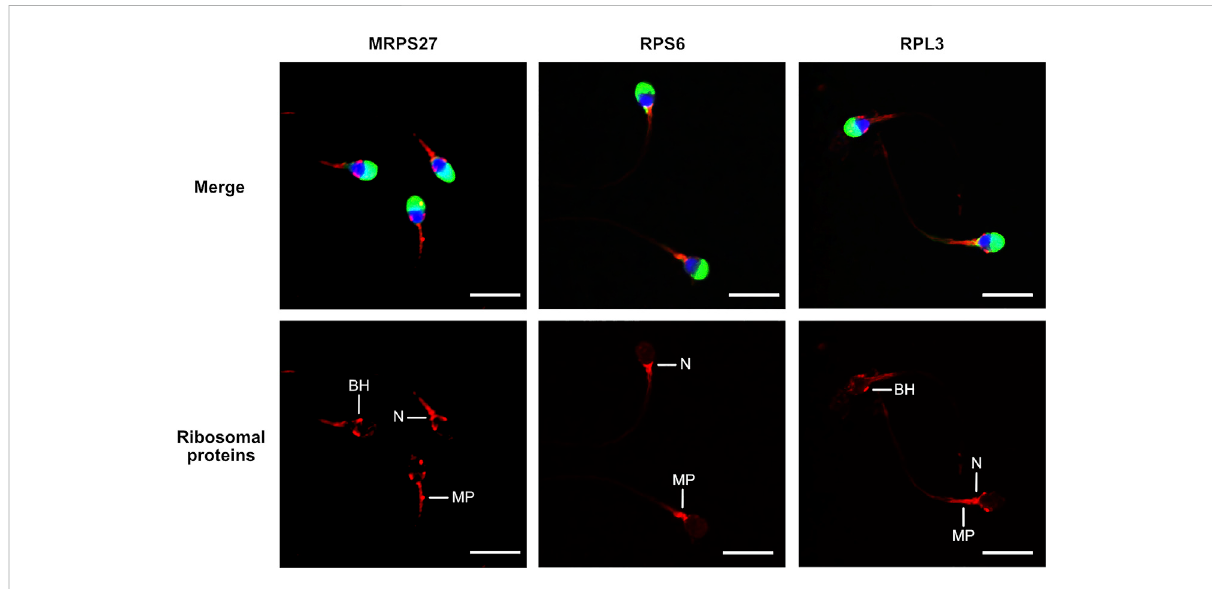
FIGURE 1 Localization of mitochondrial (MRPS27) and cytoplasmic (RPS6 and RPL3) ribosomal proteins in human spermatozoa. Puri fi ed human spermatozoa were fi xed with 4% paraformaldehyde, permeabilized with 0.3% Triton-X-100 and stained with anti-MRPS27, -RPS6, or -RPL3 antibodies.Red: Ribosomal proteins,blue:DAPI stainingof thenucleus, green: PSA-FITC staining oftheacrosome. Scalebar: 10 μ m. Representative results of N = 3 experiments. BH: base of the head, MP: Midpiece, N: